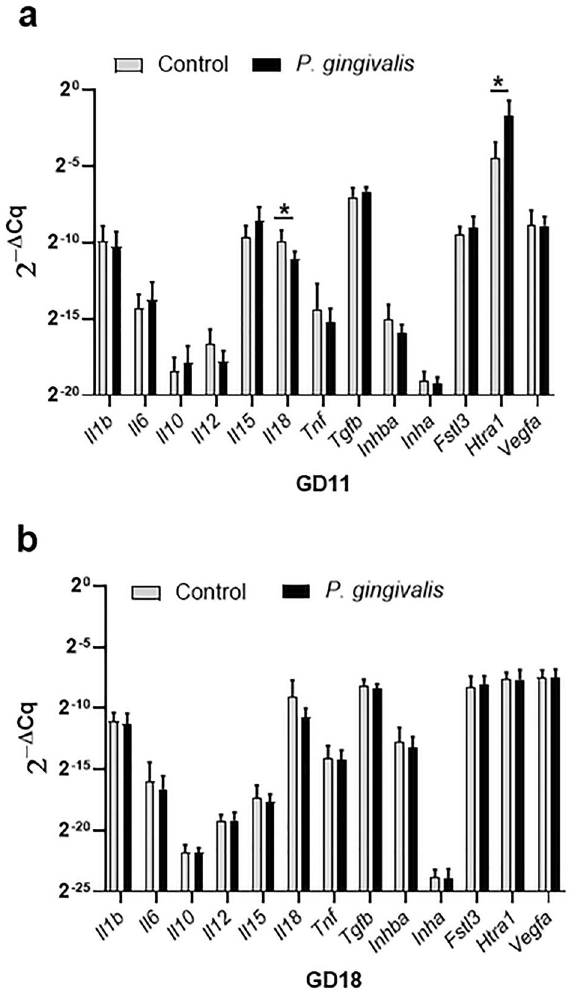
Figure 7. Placental bed gene expression profiles of GD11 ( a ) and GD18 ( b ) specimens. Cytokine and chemokine gene expression measured by RT-qPCR. Values are the mean 2 −ΔCq ± SD determined by the comparative Cq method 36 using Actb as the reference gene (n = 10). *Indicates 2 −ΔCq values that were significantly different (P < 0.05) by unpaired student’s t